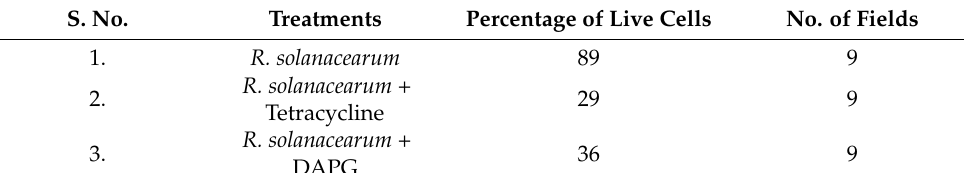
Table 4. Live/dead assay of R. solanacearum .